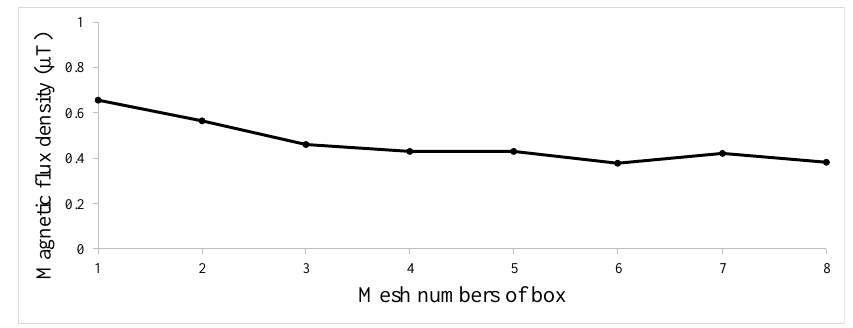
Figure 14. Difference between the maximum and minimum values of Z-component magnetic flux density, from 295.0592 mm to 307.0592 mm (values related to Hole 2), for different box mesh specifications with fixed rebar mesh #8 (Table 4).